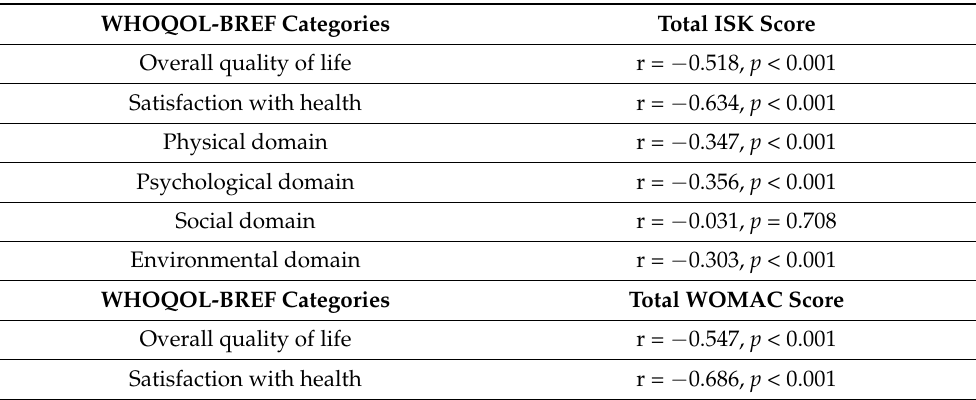
Table 8. Relationship between quality of life outcomes and lower extremity